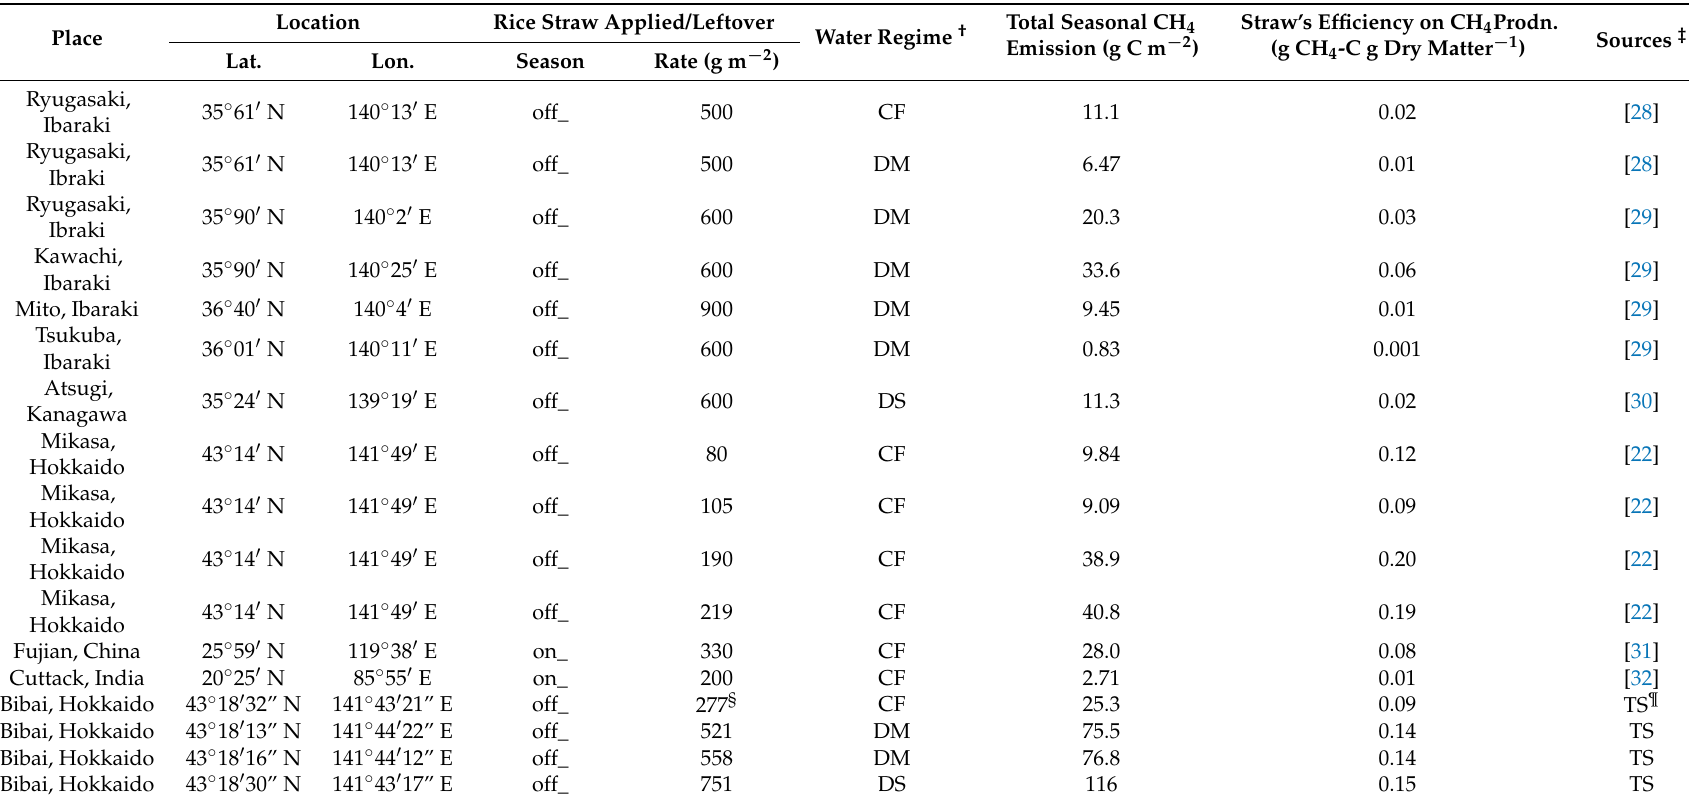
Table 5. Comparison of total seasonal CH 4 emission from paddy fields on mineral soil over peat in Central Hokkaido with those reported studies in various locations of